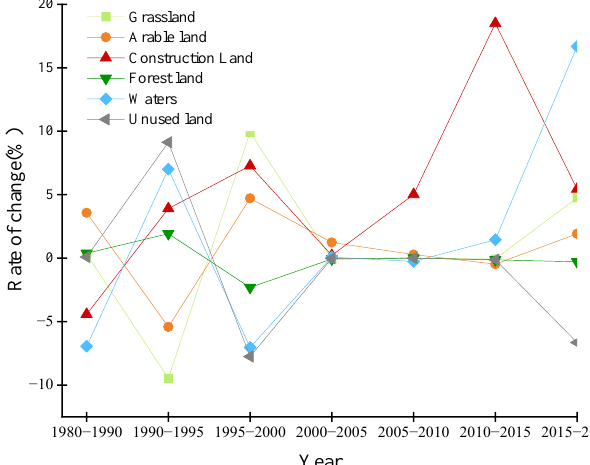
Figure 5 intuitively shows the rates of area change of land-use types in the QMs. It can be seen that during the period of 1980–1990, arable land increased the most (3.57%) and waters decreased the most ( − 6.94%); during the period of 1990–1995, unused land increased the most (9.12%) and grassland decreased the most ( − 9.47%); during the period of 1995–2000, grassland increased the most (9.92%) and unused land decreased the most ( − 7.76%); arable land increased the most (1.24%) and forest land decreased the most ( − 0.07%) between 2000 and 2005; construction land increased the most (5.02%) and waters decreased the most ( − 0.25%) between 2005 and 2010; between 2010 and 2015, the largest increase was in construction land (18.50%) and the largest decrease was in arable land ( − 0.47%); and between 2015 and 2020, the largest increase was in waters (16.68%) and the largest decrease was in unused land ( − 6.65%).